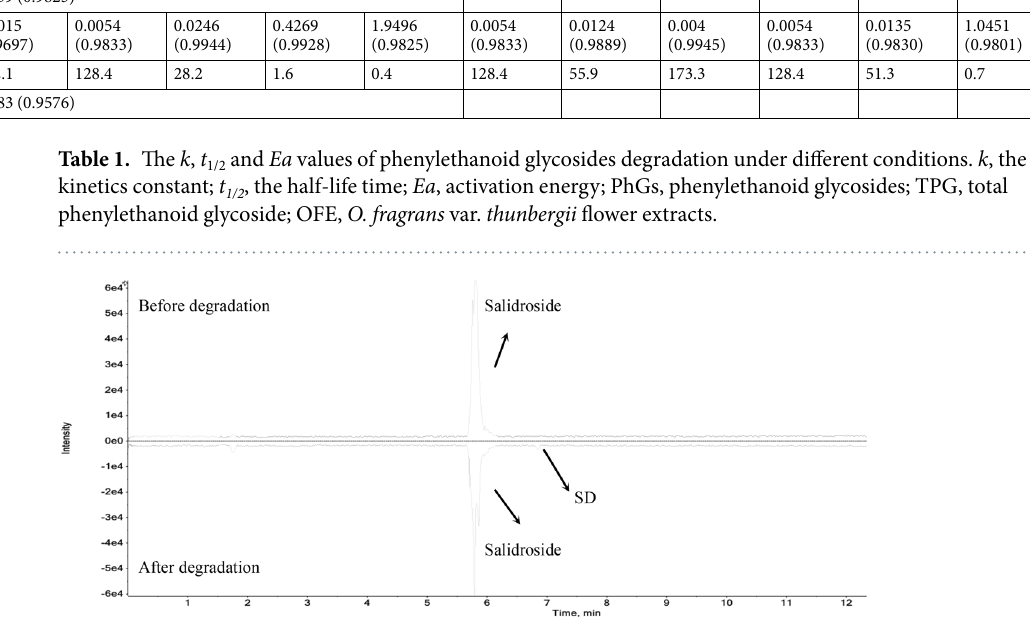
Figure 2. Total ion chromatogram of salidroside before and after degradation in positive ion mode. SD: salidroside degradation